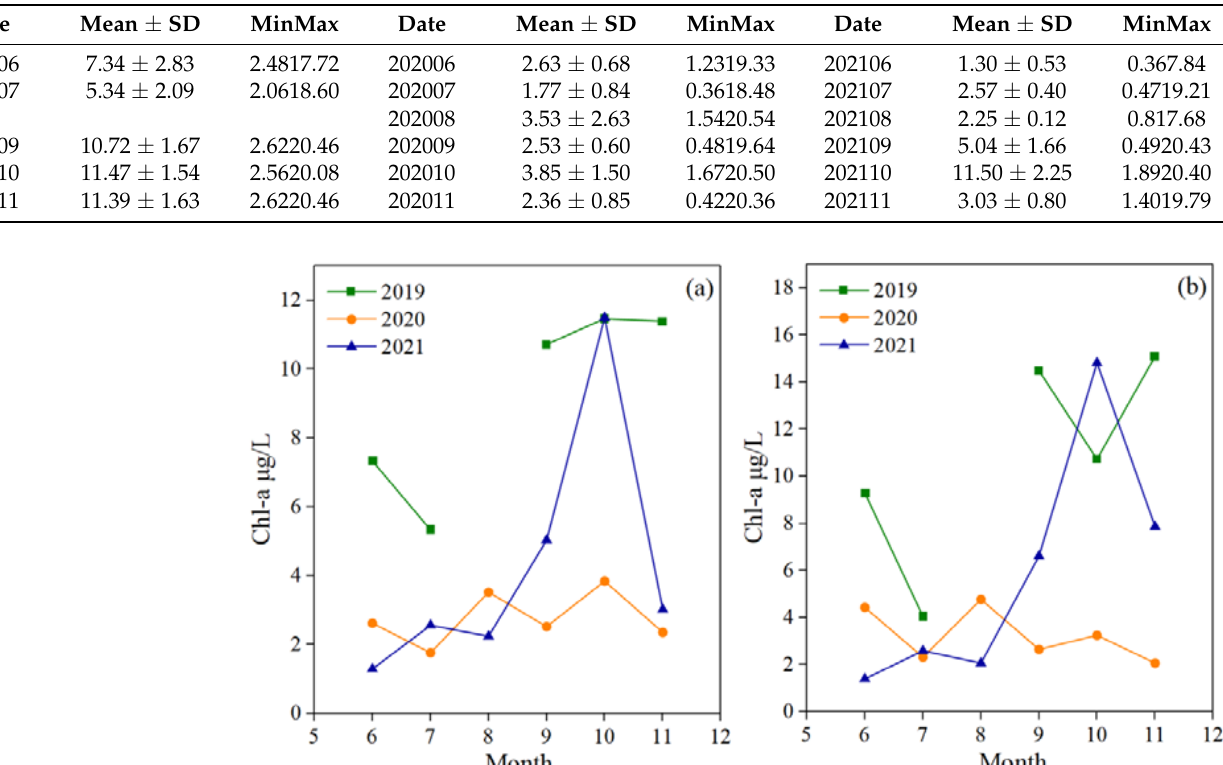
Figure 6. Monthly average values of Chl-a concentration inversion results with GF-6 WFV images from 2019 to 2021. ( a ) The average value of Chl-a concentration in Da Xingkai Lake; ( b ) the average value of Chl-a concentration in Xiao Xingkai Lake.